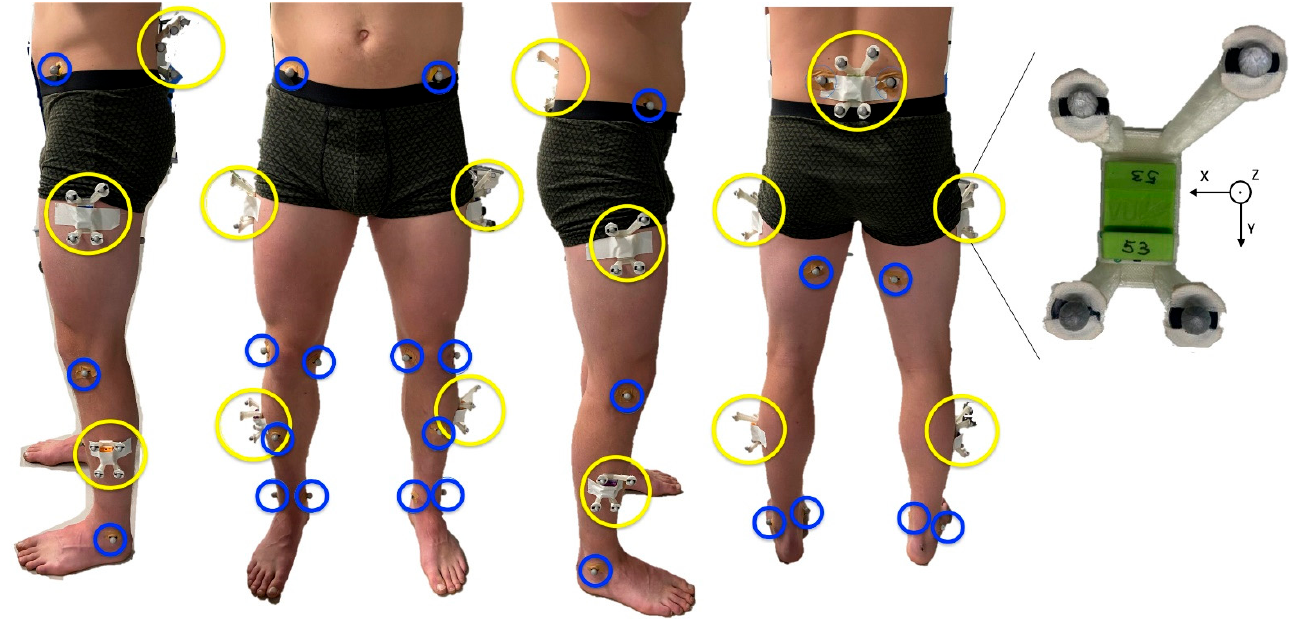
Figure 1. Subject instrumentation. IMUs were placed in the Rigid Marker Clusters and placed on the left and right thigh, left and right shank and pelvis, represented by yellow circles in the figure. An enlarged RMC is shown on the right-hand side. Markers were placed on the following anatom- ical landmarks: the anterior and posterior superior iliac spines, the posterior side of the thighs half- way the length hip to knee, the medial and lateral femoral epicondyles, the anterior side of each shank halfway the length knee to ankle and the medial and lateral malleoli, represented by blue circles in the